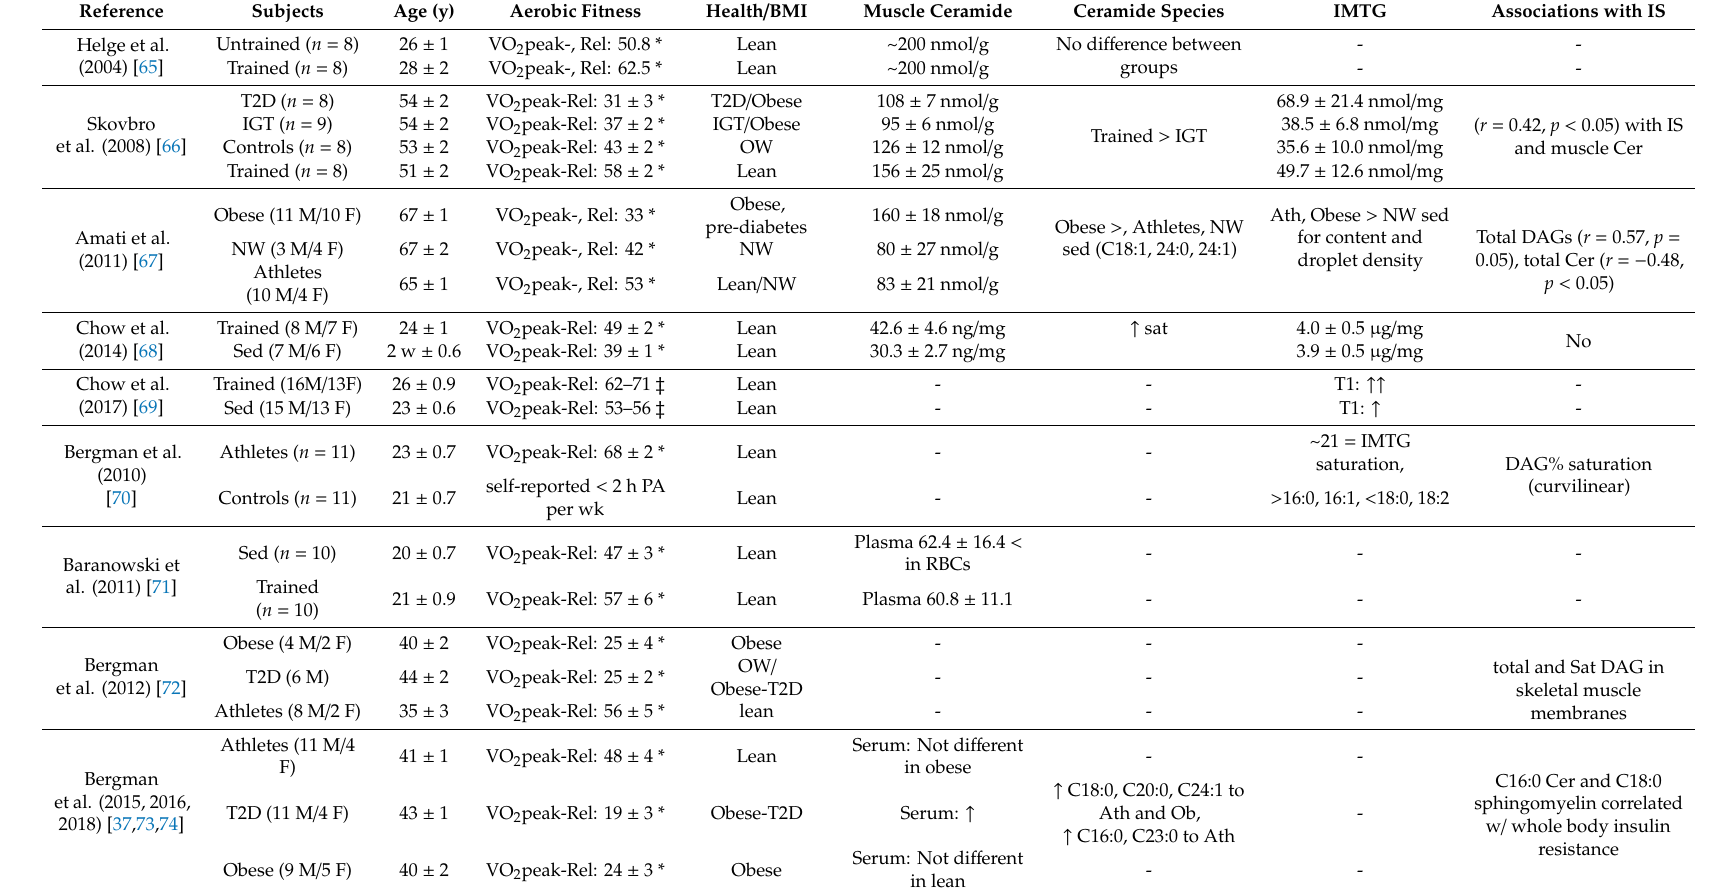
Table 3. Cross-sectional studies and muscle ceramides in